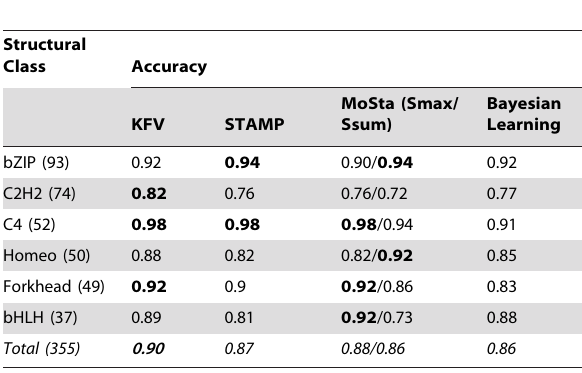
Table 4. Comparison of the KFV algorithm with other methods for motif retrieval using